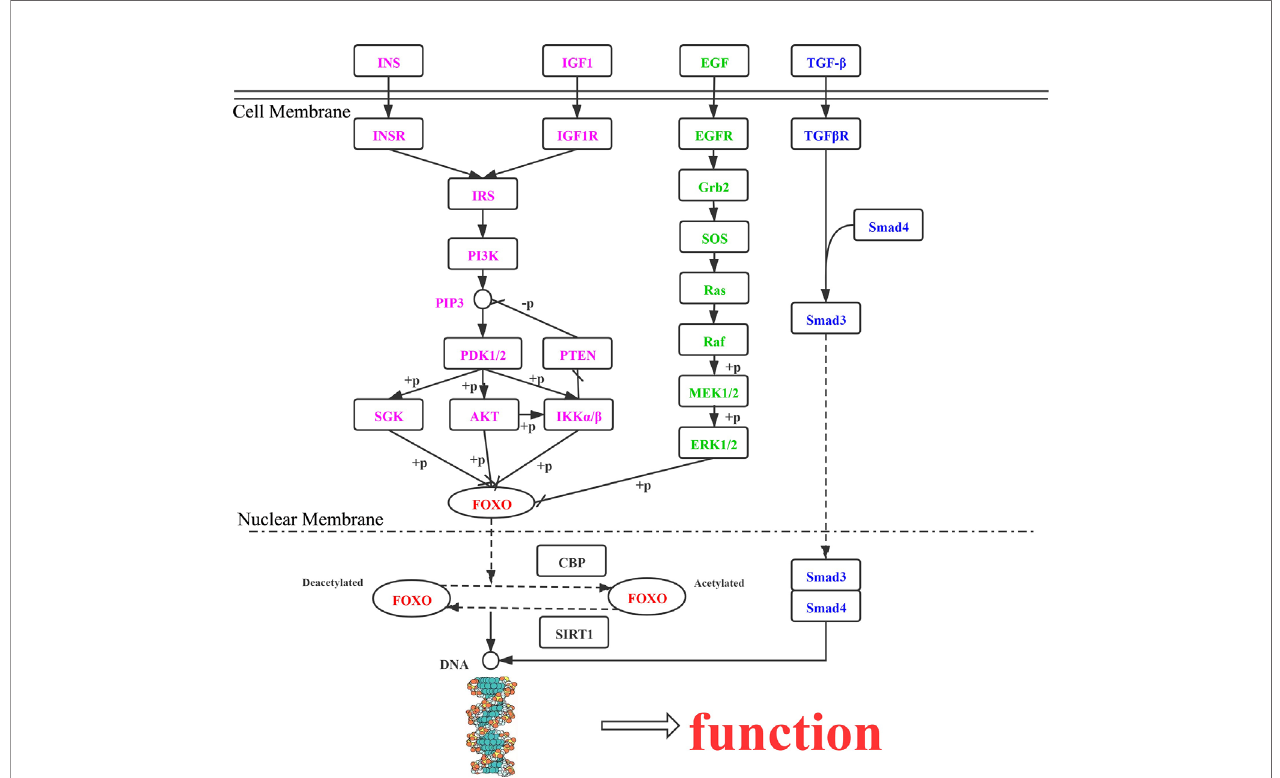
FIGURE 2 | Roles of FOXO proteins in tumor cells, mediated via the PI3K/AKT, MAPK, IKK, and TGF- b signaling pathways. INS, insulin; INSR, insulin receptor; IRS, insulin receptor substrate; PIK3, phosphatidylinositol-4,5-bisphosphate 3-kinase; PDK, 3-phosphoinositide dependent protein kinase-1; AKT, RAC serine/threonine- protein kinase; SGK, serum/glucocorticoid-regulated kinase 1; IKK, inhibitor of nuclear factor k - b kinase subunit a ; PTEN, phosphatidylinositol-3,4,5-trisphosphate 3- phosphatase and dual-speci fi city protein phosphatase PTEN; IGF1R, insulin-like growth factor 1 receptor; IGF1, insulin-like growth factor 1; TGF b 1, transforming growth factor b -1; TGF b R1, TGF- b receptor type-1; SMAD4, mothers against decapentaplegic homolog 4; SMAD3, mothers against decapentaplegic homolog 3; EGF, epidermal growth factor; EGFR, epidermal growth factor receptor; GRB2, growth factor receptor-bound protein 2; SOS, son of sevenless; RAS, GTPase HRas; BRAF, B-Raf proto-oncogene serine/threonine-protein kinase; MEK1, mitogen-activated protein kinase kinase 1; ERK, mitogen-activated protein kinase 1/3; CBP, E1A/CREB-binding protein; SIRT1, NAD+-dependent protein deacetylase sirtuin